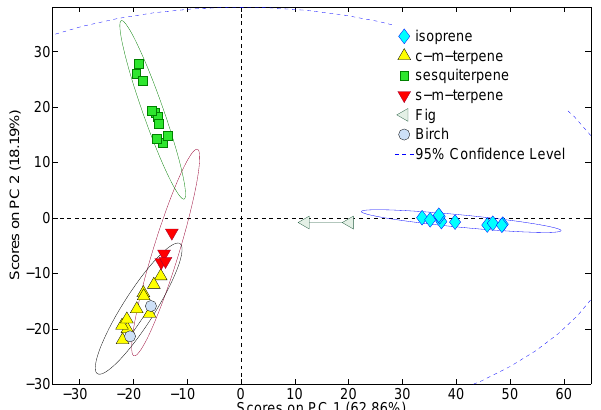
Figure 3. PCA scores plot of the second vs. first principal compo- nents derived from the PCA analysis of the mesocosm test set using the PCA model derived from the isoprene, cyclic monoterpene ( α - pinene and limonene), sesquiterpene ( β -caryophyllene) and straight chain monoterpene (myrcene and linalool) chamber data. Classifi- cation confidence level is 95%.